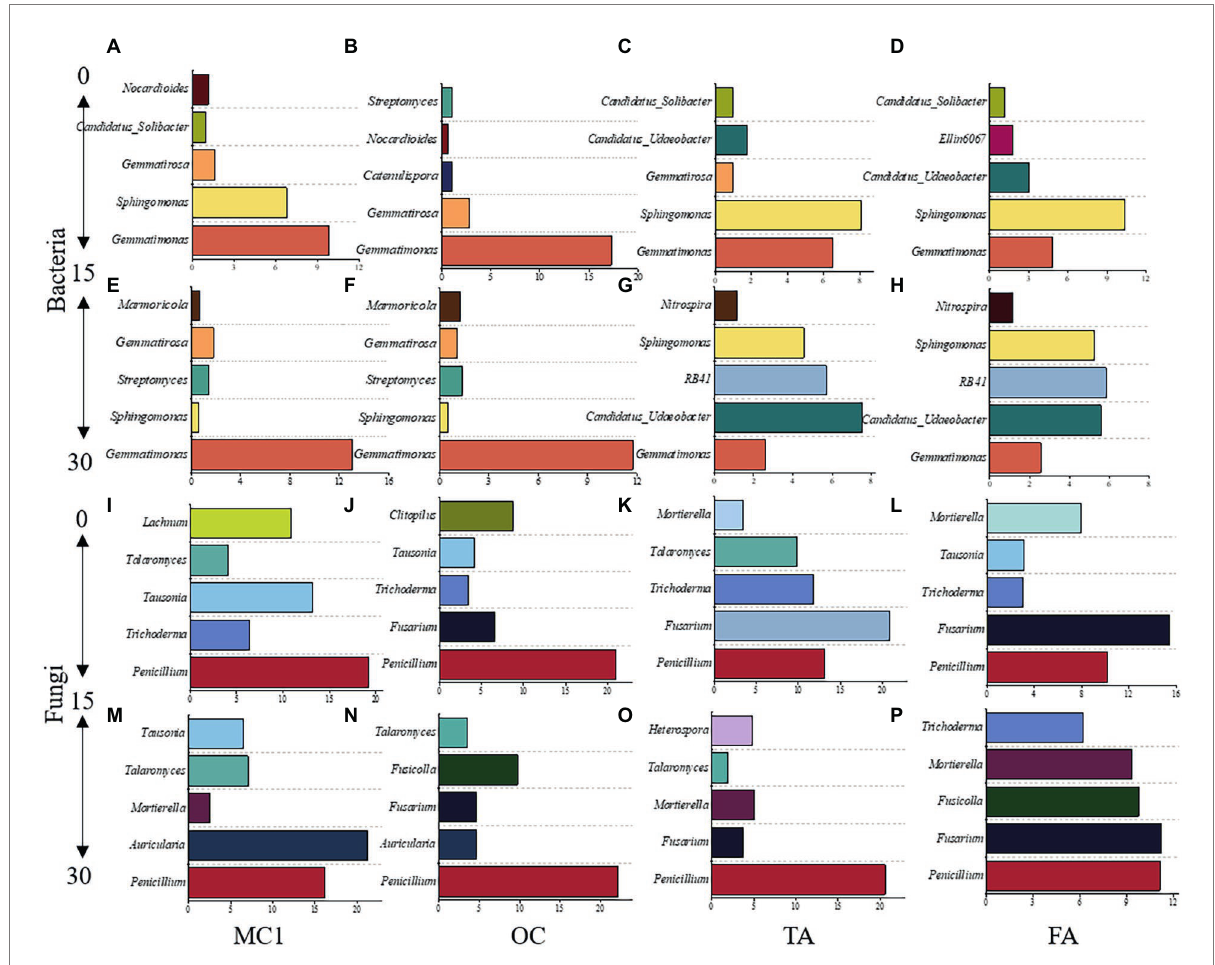
FIGURE 4 The top five dominant genera at the soil depths of 0-15 cm and 15-30 cm under different treatments. The dominant bacterial genera at the 0-15 cm soil depth (A-D) and 15-30 cm soil depth (E-H) . The dominant fungal genera at the 0-15 cm soil depth (I-L) and the 15-30 cm soil depth (M-P)